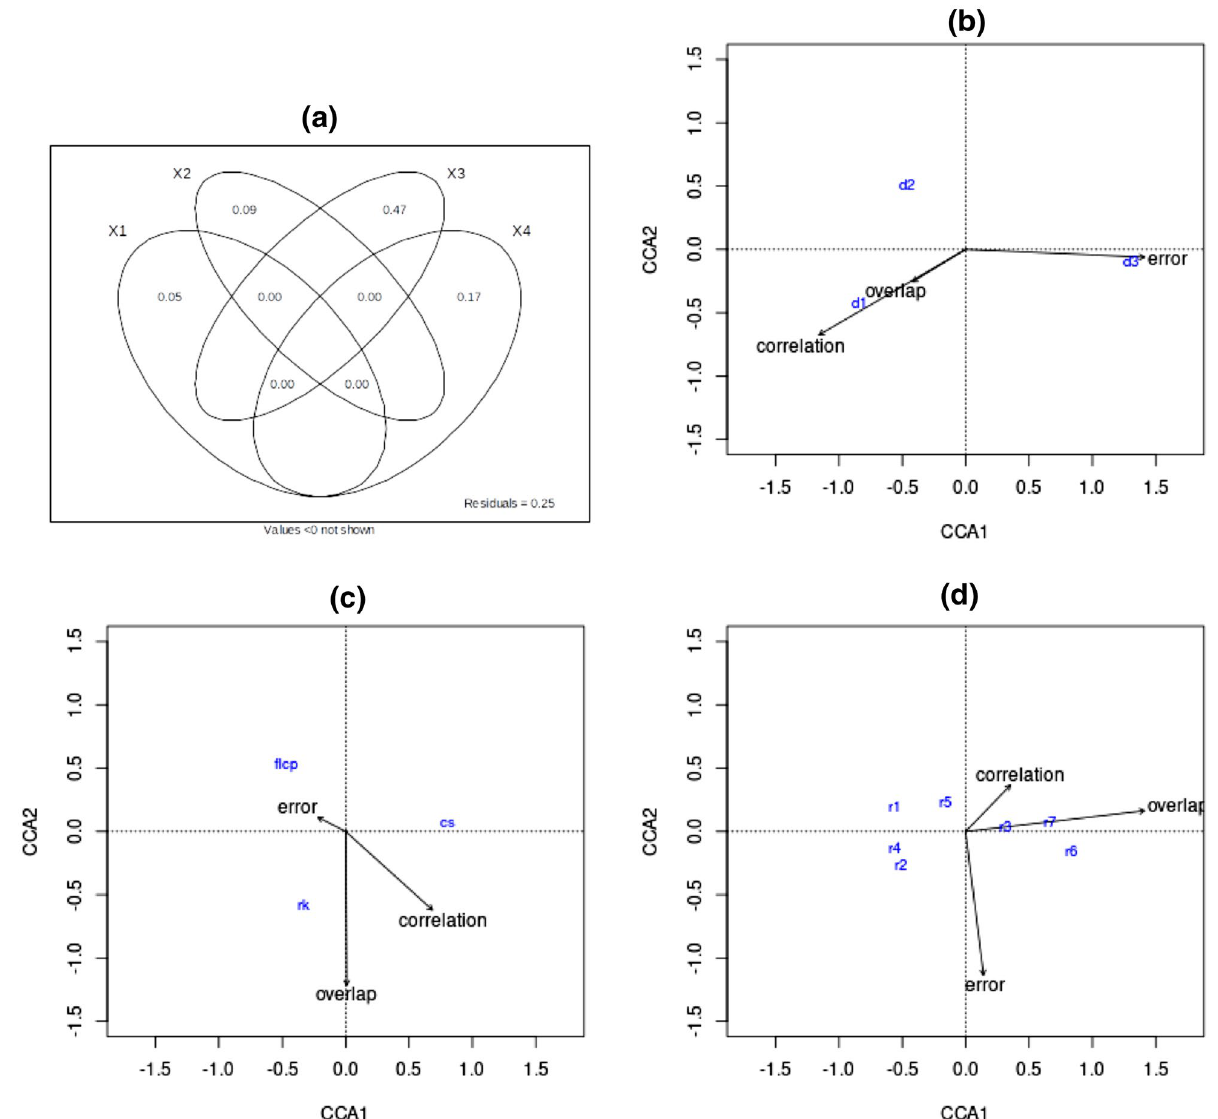
Figure 6. Variance partitioning ( a ) and canonical correspondence analyses ( b – d ) for the second investigation. A key to the CCA figure labels is provided in Supplementary Table S2. The variance partitioning now shows destination bias to be the primary factor determining the accuracy of connectivity predictions, approximately thrice as influential as model choice (X4), which in turn has a much greater effect on predictive accuracy than movement mechanism (X1) and spatial complexity (X2). In ( b ), we see that a lower degree of destination bias gives predictions which are more accurate across all three statistics. In ( c ) we find that predictions by resistant kernels overall give the highest overlap, and those by Circuitscape result in the least error, whereas factorial least-cost paths is seen to be the least accurate. ( d ) suggests that, with destination bias, higher spatial complexity now results in more accurate model predictions, with an increase in overlap and minor increase in correlation as spatial variation increases.